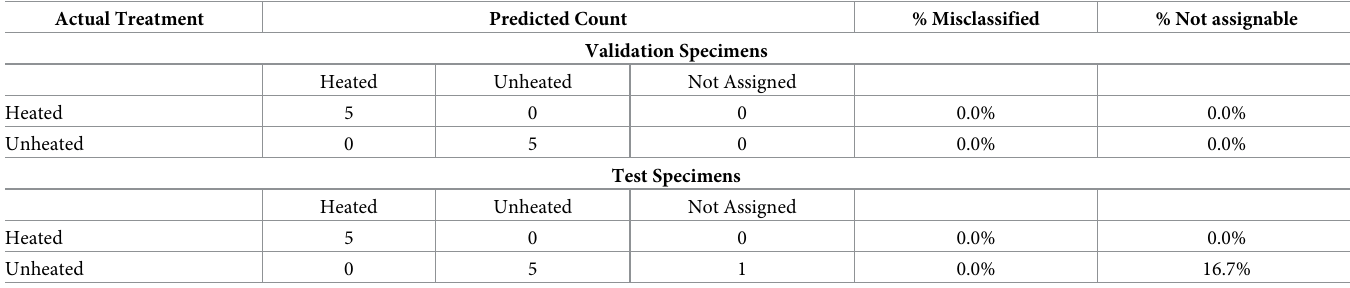
Table 6. k-NN model A specimen-level prediction